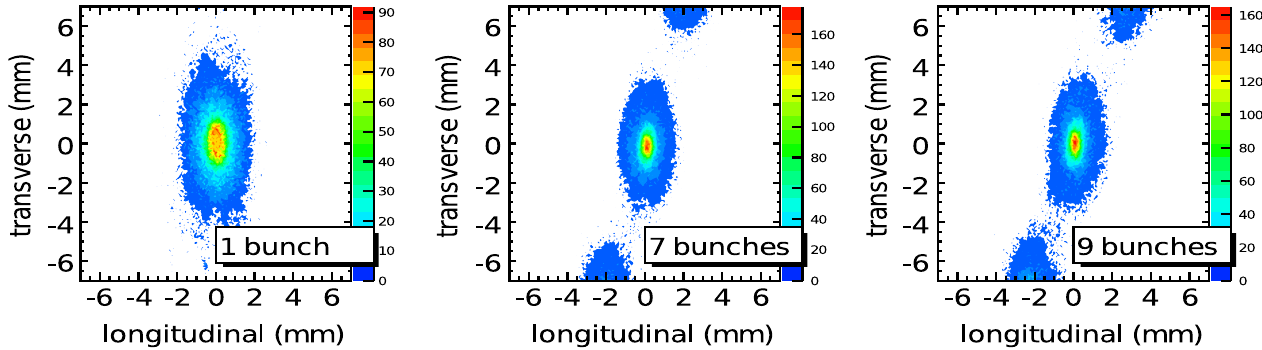
FIG. 11. (Color) Top view of 1 mA bunch distributions at the turn 130 in the local frame S 130 in the PSI ring cyclotron. The results are obtained from single bunch (left), seven bunches (middle), and nine bunches (right) simulations,